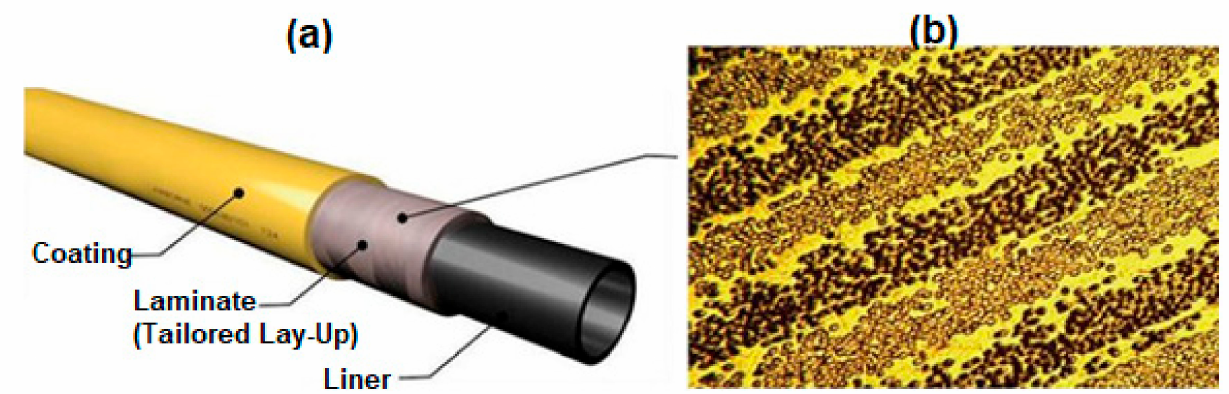
Figure 8. Depiction of ( a ) design concept of TCP pipes and ( b ) laminate microscopy. (Reproduced with permission of Jak Annemarie and Martin van Onna; Courtesy of Airborne